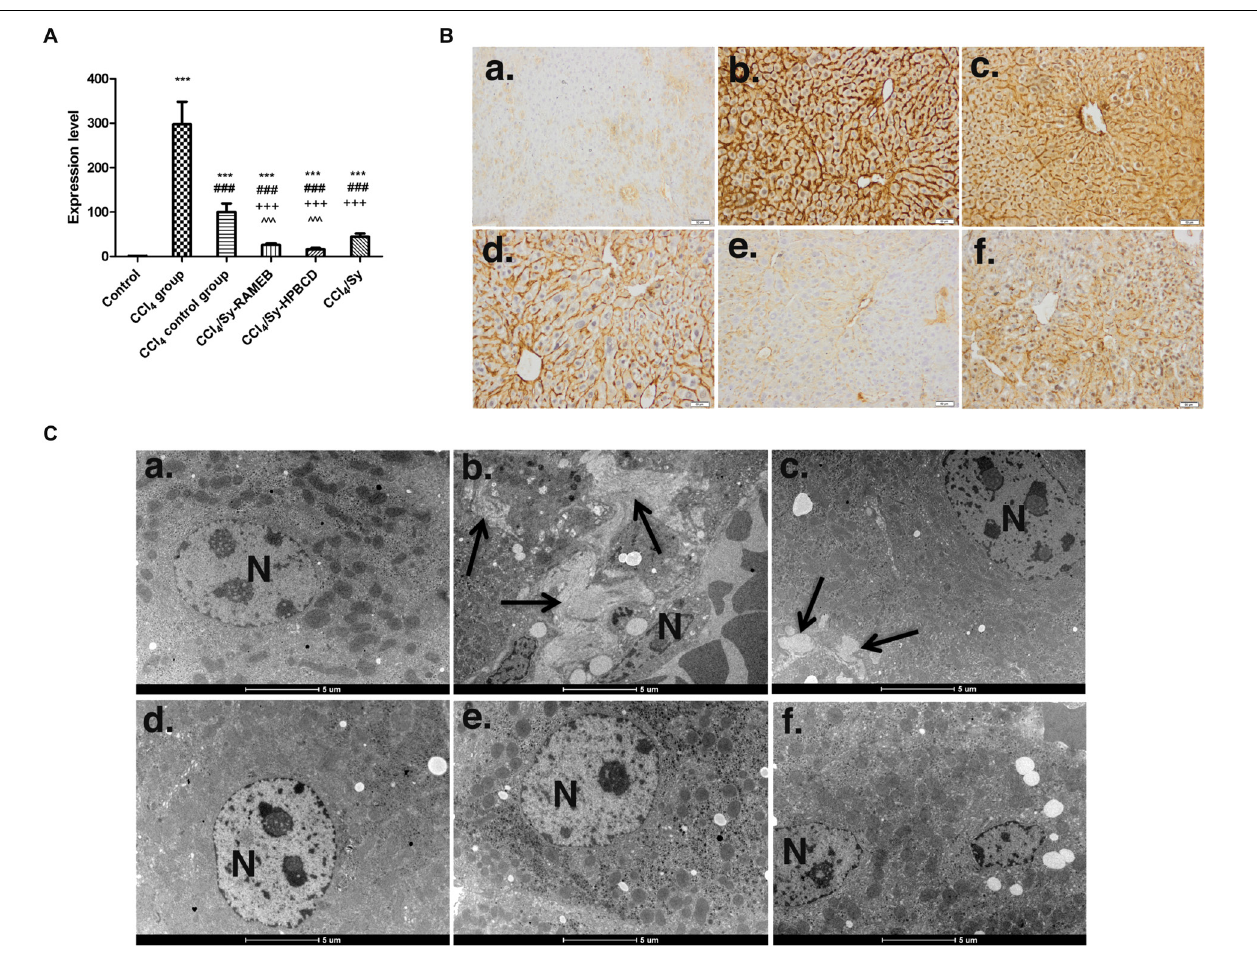
FIGURE 8 | Effects of Sy-HPBCD and Sy-RAMEB complexes on collagen over-production. (A) RT-PCR analysis of Col 1 gene level. ∗∗∗ p < 0.001 compared to control; ### p < 0.001 compared to CCl 4 group; +++ p < 0.001 compared to CCl 4 control group; ˆ p < 0.05 compared to CCl 4 /Sy group; ˆˆˆ p < 0.001 compared to CCl 4 /Sy group. (B) Immunohistochemical expression of Col 1 in experimental livers. (a) Control group, (b) CCl 4 -treated group, (c) CCl 4 -control group, (d) CCl 4 and Sy-RAMEB co-treated group, (e) CCl 4 and Sy-HPBCD co-treated group, (f) CCl 4 and free Sy co-treated group. (C) Collagen deposition in experimental livers by electron microscopy. (a) Control group, (b) CCl 4 -treated group, (c) CCl 4 -control group, (d) CCl 4 and Sy-RAMEB co-treated group, (e) CCl 4 and Sy-HPBCD co-treated group, (f) CCl 4 and free Sy co-treated group; Collagen fibers (arrow); N,